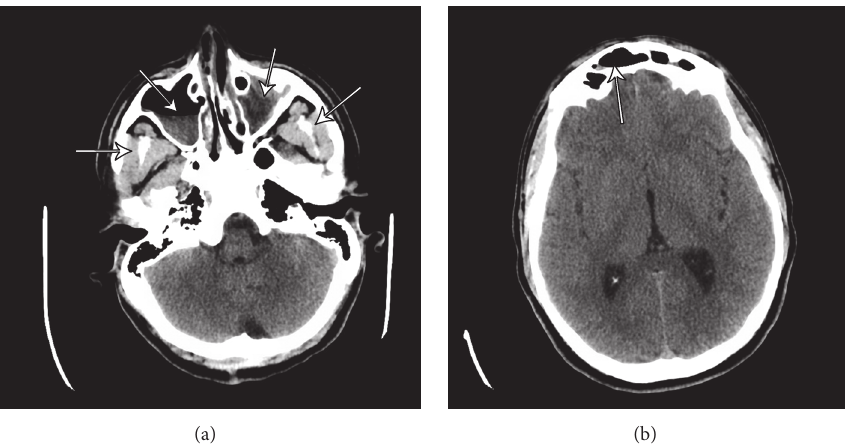
Figure 1: (a) illustrates severe sinusitis involving the ethmoid air cells and left maxillary sinus, moderate involvement of the right maxillary sinus, and mild involvement of the frontal sinuses. (b) shows a 3 cm extra-axial structure in the left frontal region, epidural in location.